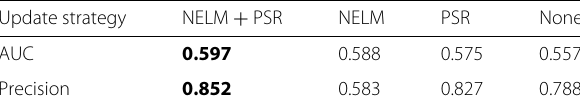
as shown in Table 3. The best results are in bold. On the OTB-15 dataset, the combination of the features extracted from conv3 and conv4 layers achieves the best results, which verifies the rationality of the feature selection of the proposed algorithm. Table 3 Results of different